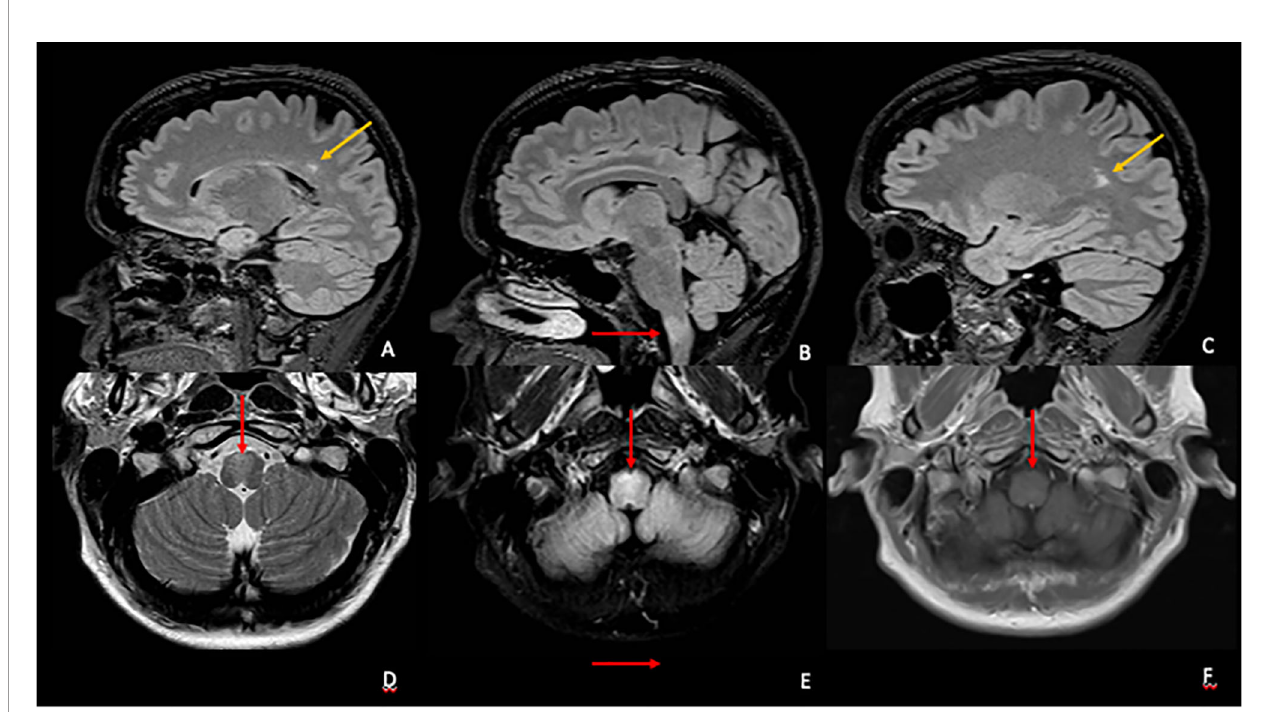
FIGURE 1 | Top row (A – C) Sagittal volumetric fl uid-attenuated inversion recovery (FLAIR) images showing at least two periventricular hyperintense lesions (yellow arrows) with perivenular distribution and one ventral medula oblongata lesion (red arrow). Bottom row — Axial T2 (D) , FLAIR (E) , and T1 pos gadolinium (F) images showing the ventral medulla oblongata hyperintense lesion compromising pyramidal decussation (D, E) without gadolinium enhancement (F)